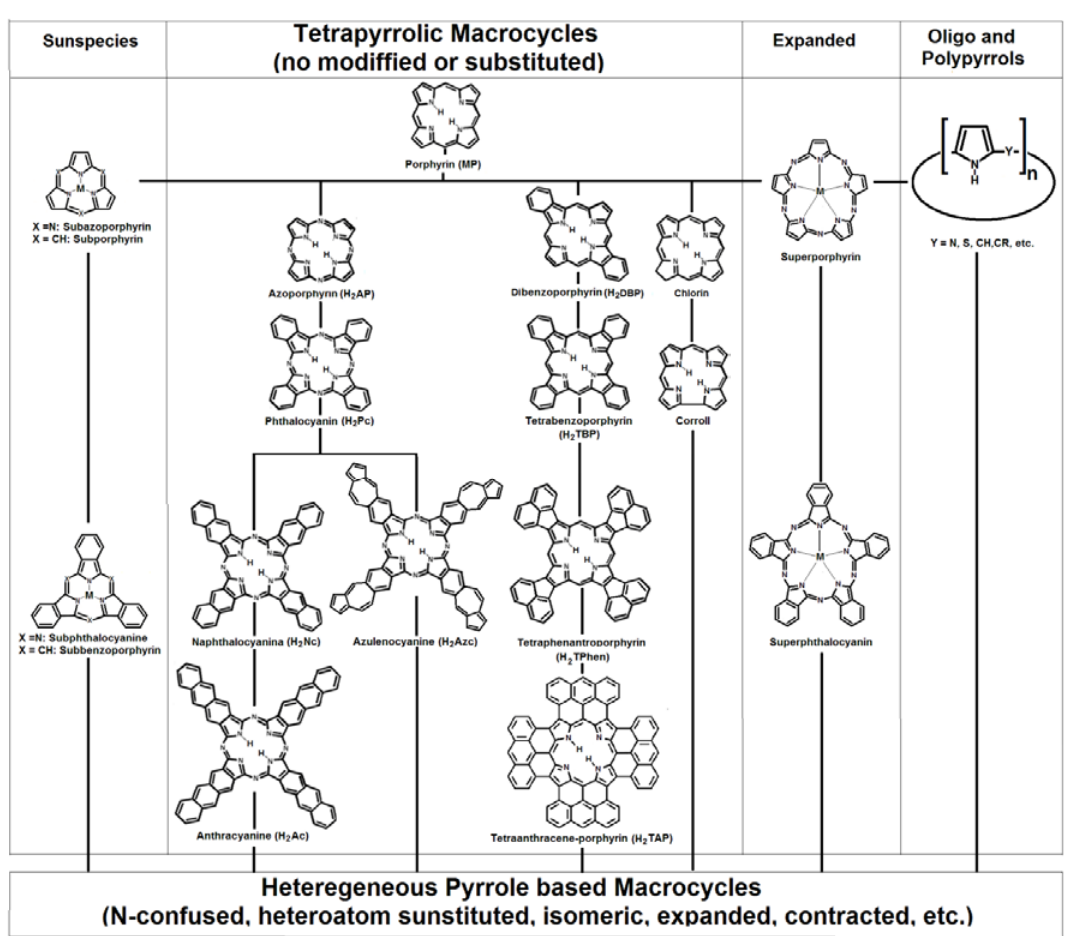
Figure 3. Tetrapyrrolic macrocycles, such as porphyrins, phthalocyanines, naphthalocyanines, chlorines, and corrolls, can be classified as homogeneous pyrrole derivatives. The linking lines drawn only interrelate structurally similar species; for clarity, the nonsymmetric, modified or/and substituted members of this family have been